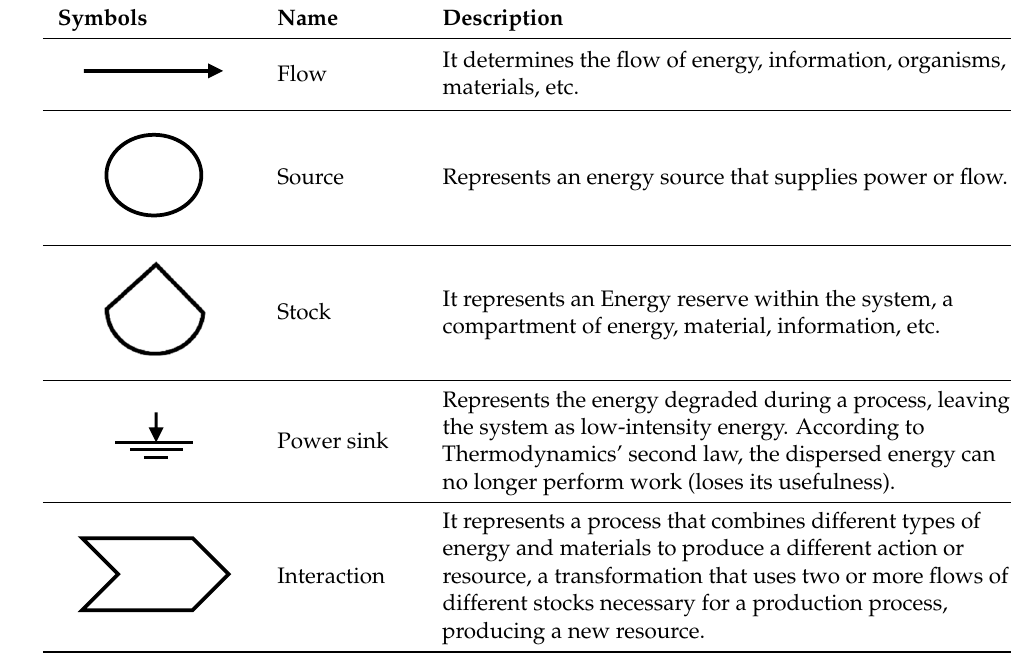
Table 1. Main symbols used in constructing diagrams for emergy assessment proposed by Daley (2013) [22].